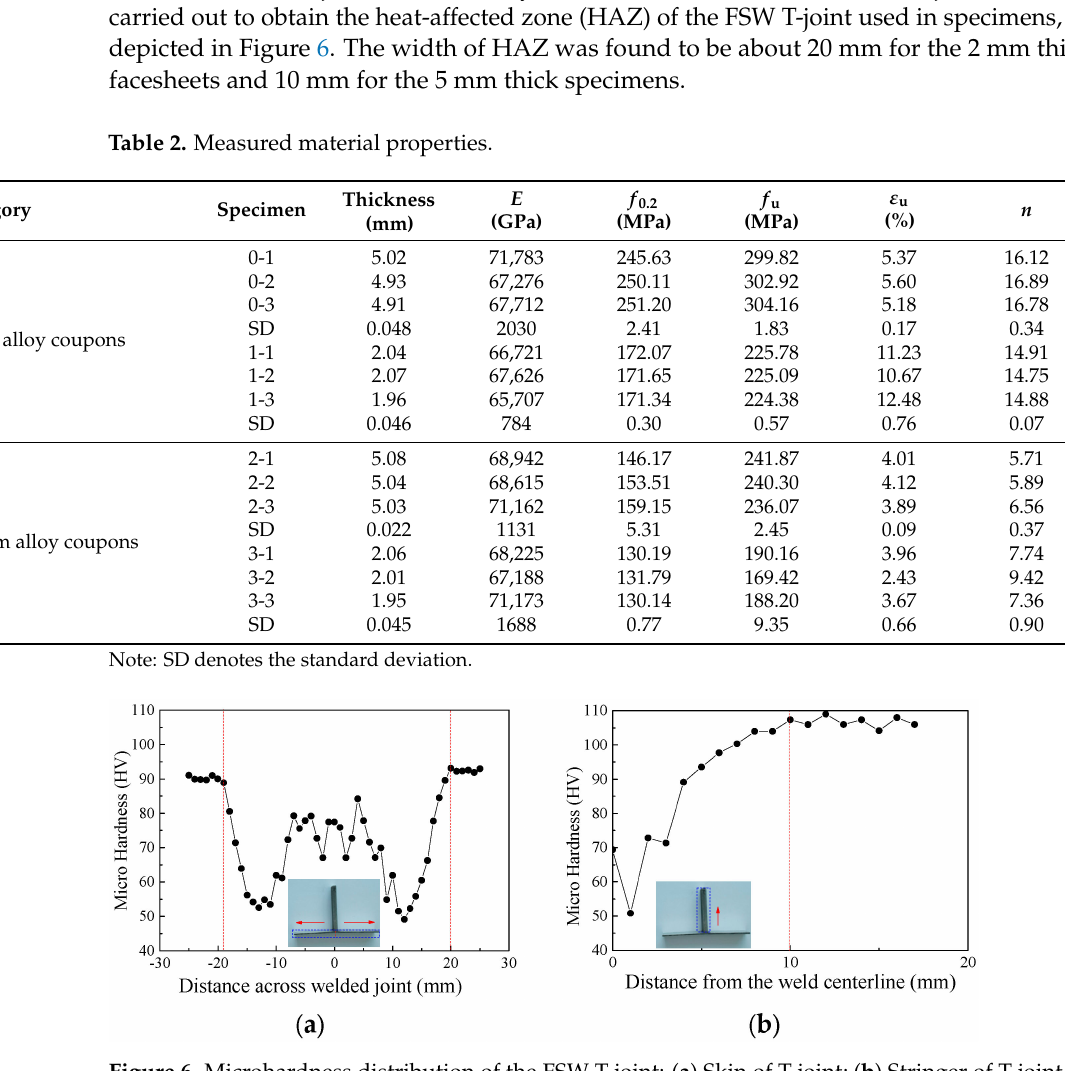
Figure 6. Microhardness distribution of the FSW T-joint: ( a ) Skin of T-joint; ( b ) Stringer of